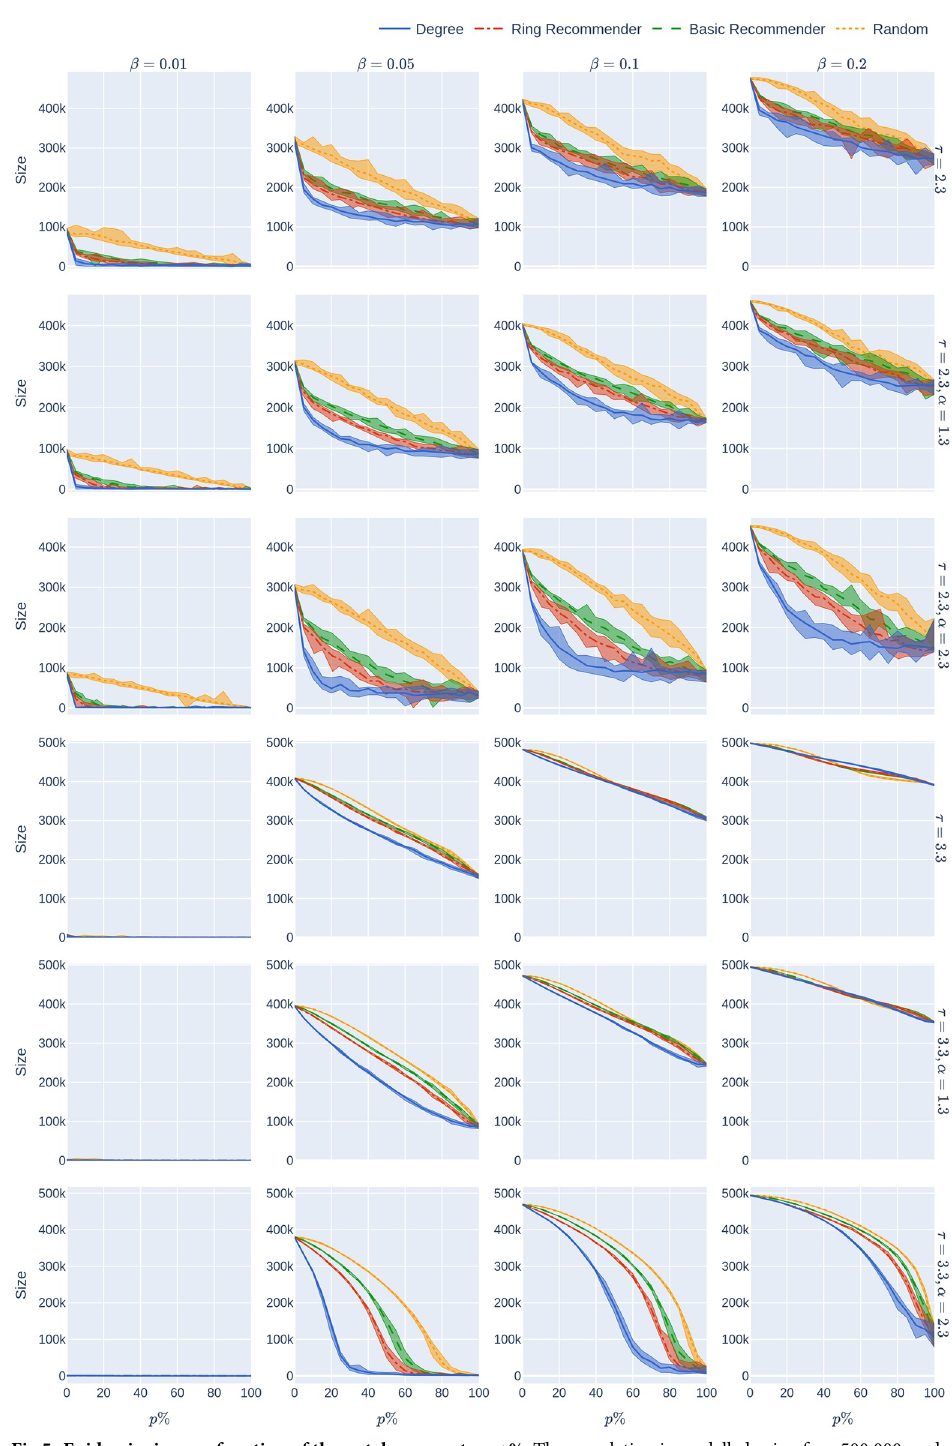
Fig 5. Epidemic size as a function of the uptake percentage p %. The population is modelled using four 500,000-node GIRG networks where τ = 2.3 has more super-spreaders and τ = 3.3 has fewer super-spreaders, α = 1.3 is less geometric and α = 2.3 is more geometric, arranged in the four rows. For comparison, there are two rows for 500,000-node configuration models with τ = 2.3 and τ = 3.3. The x -axis shows the uptake percentage p % varying from 0 to 100% at step size 5%. Simulations are done for the 21 values of p % corresponding to these steps. The y -axis shows the corresponding value Size( p ). Different columns indicate varying infection probabilities β . The epidemic size data in